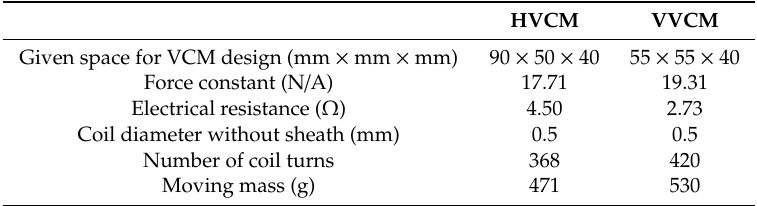
Table 4. Space limitation and specifications of the fabricated HVCM and